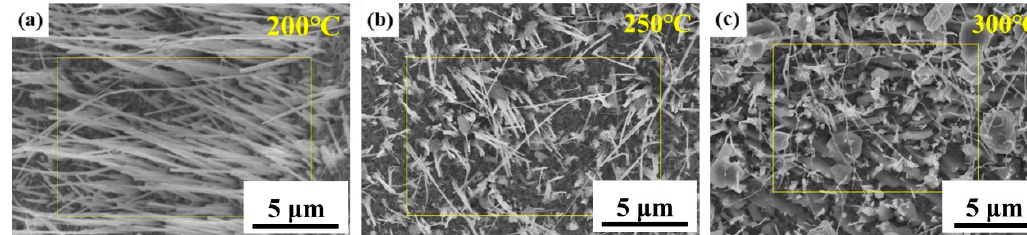
Figure 2. FE-SEM images of CuO nanowires under sulfurization process at different temperatures ( a ) 200 °C, ( b ) 250 °C, ( c ) 300 °C.